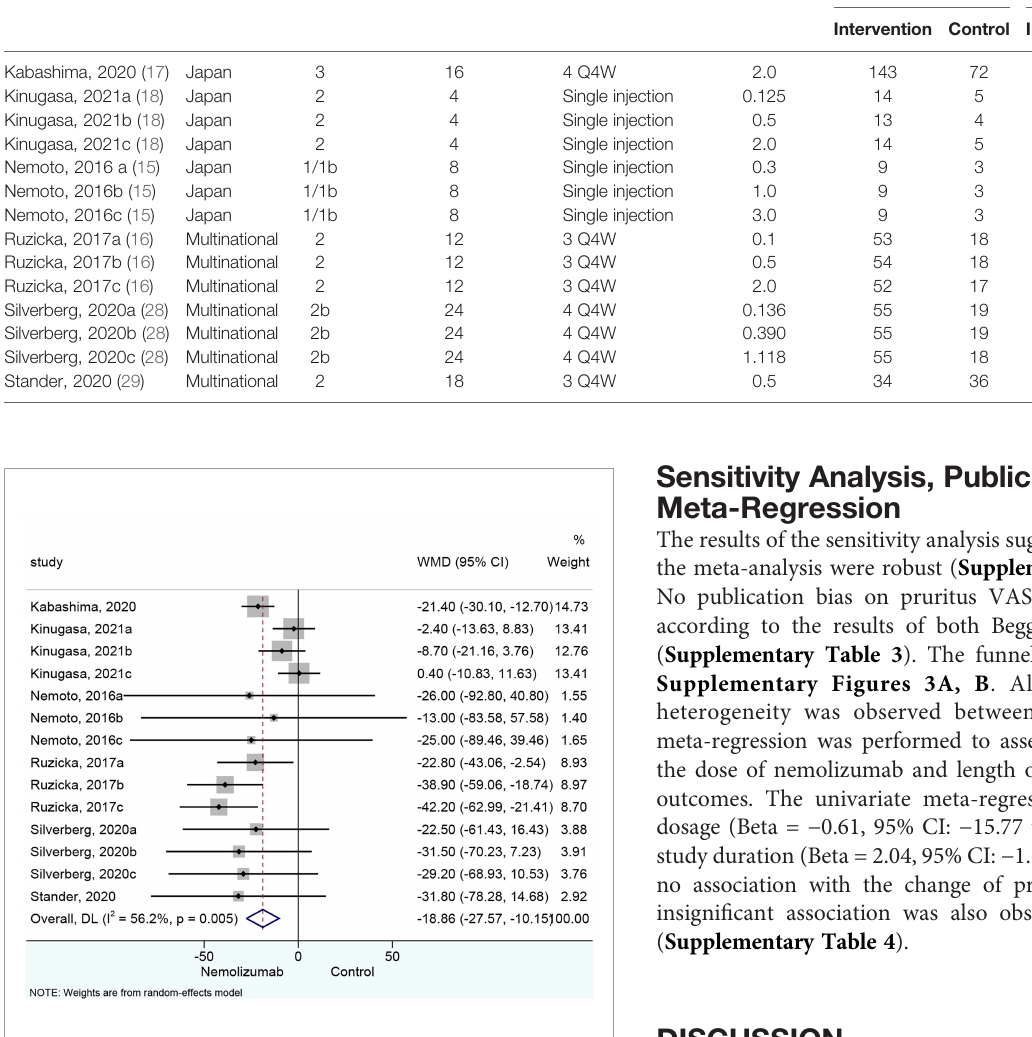
FIGURE 2 | Forest plot of pruritus visual analog scale comparing nemolizumab and